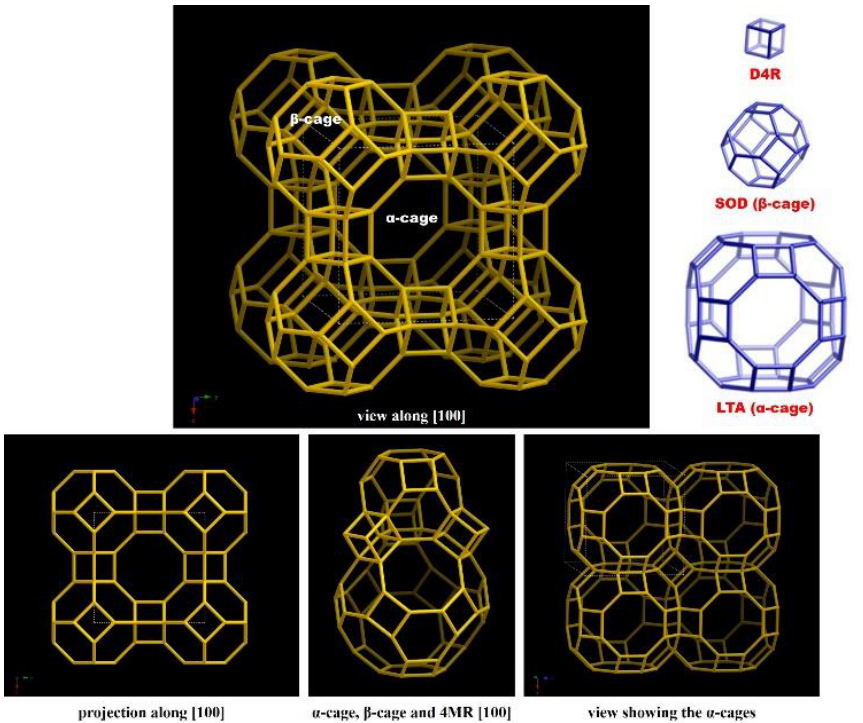
Figure 3. The structural framework of zeolite Lynde type A (LTA), showing its characteristic cages and channels. The vertices mark the positions of the T atoms, the lines symbolize the oxygen bridges between them. Diamond Crystal Structure Software Version 2.1 (structural data published by the International Zeolite Association).